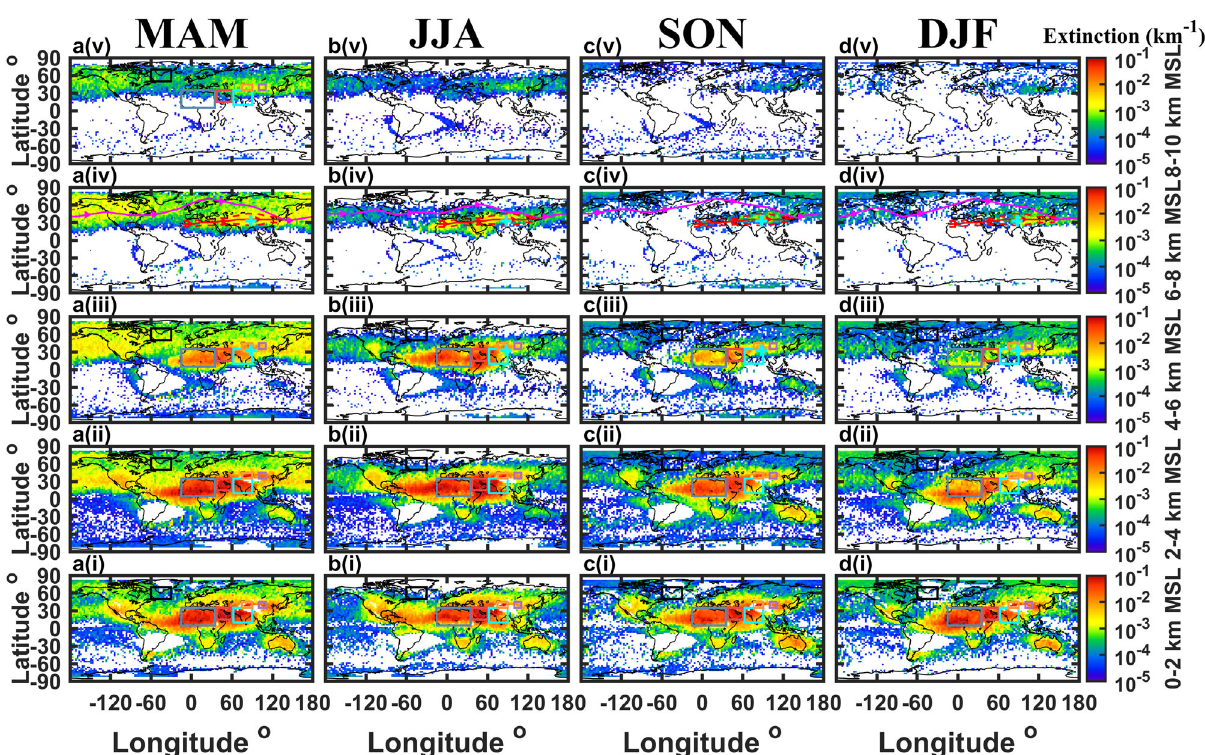
Fig. 1 Seasonal dust extinction distribution at fi ve height levels. From left to right the four columns ( a – d ) are four seasons March – April – May (MAM), June – July – August (JJA), September – October – November (SON), and December – January – February (DJF), respectively. From bottom to top the fi ve rows (i – v) are fi ve different levels: 0 – 2 km, 2 – 4 km, 4 – 6 km, 6 – 8 km, and 8 – 10 km above mean sea level (MSL). In rows i, ii, iii, and a(v), the fi ve colored boxes indicate fi ve major dust source regions in the northern hemisphere, the black box indicate the “ transport region ” ( − 60° to − 30° longitude, 50°N – 70°N latitude) away from source regions. The cyan plus sign in rows iii and iv marks the location of the Tibetan Plateau (TP). The red and purple lines in row iv are dust transport tracks selected (based on subtropical and polar jet center positions), with small triangles indicating the transport directions. Dust extinction is shown for those pixels with dust occurrence (de fi ned as total detected dust case numbers divided by total all sky observation numbers) larger than 0.01. The white region over South America indicates the South Atlantic Anomaly (SAA) impacted region without reliable dust detection due to high CALIOP noise